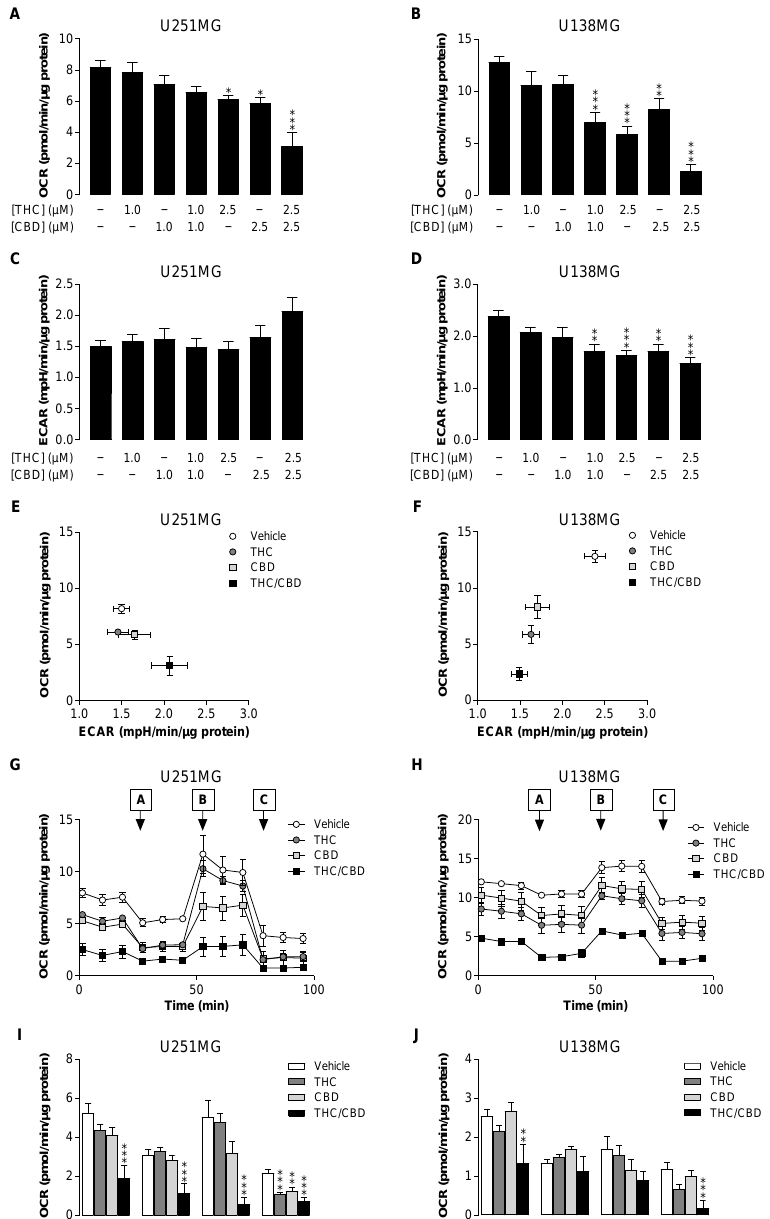
Figure 2. Influence of THC and CBD, administered alone or in combination, on oxygen consumption rate (OCR) and extracellular acidification rate (ECAR) of human glioblastoma cells. U251MG and U138MG cells were incubated with selected concentrations of THC and CBD, their combination (in a ratio of 1:1) or the vehicle control for 24 h. Thereafter, OCR ( A , B ) and ECAR ( C , D ) were determined using the Seahorse XFe24 Analyser. The effects of selected treatment groups on OCR and ECAR are summarised in the energy maps in panels ( E , F ). Subsequently, a mitochondrial stress test was performed. For this purpose, the sensor cartridges were loaded at the indicated times with 1.5 µM oligomycin (port A), 1.0 µM FCCP (port B) and 0.5 µM each of antimycin A and rotenone (port C). Panels ( G , H ) show representative time courses of OCR in both cell lines treated with 2.5 µM THC and/or CBD. Panels ( I , J ) present calculations of basal respiration (basal), ATP-bound respiration (ATP), reserve respiratory capacity (spare) and proton leak. The data represent mean values ± SEM of n = 6–9 of 3 independent experiments per group ( A – F , I , J ), or n = 2–3 of 1 experiment per group ( G , H ). * p ≤ 0.05, ** p ≤ 0.01, *** p ≤ 0.001 vs. corresponding vehicle control, one-way ANOVA with Dunnett’s post hoc test.